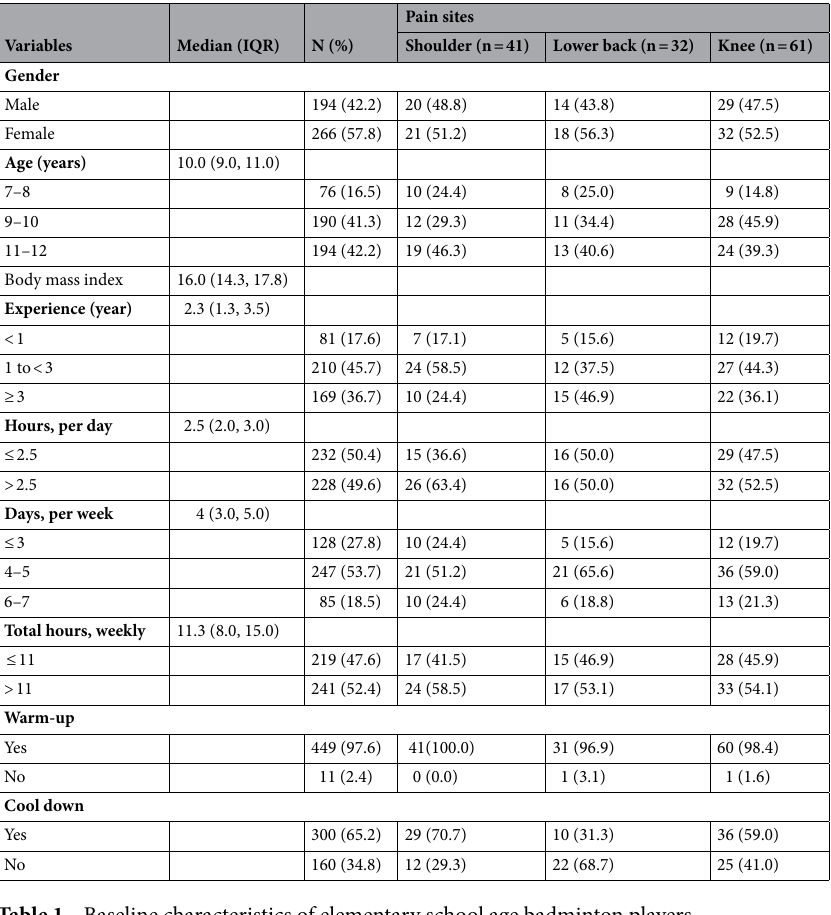
Table 1. Baseline characteristics of elementary school age badminton players.